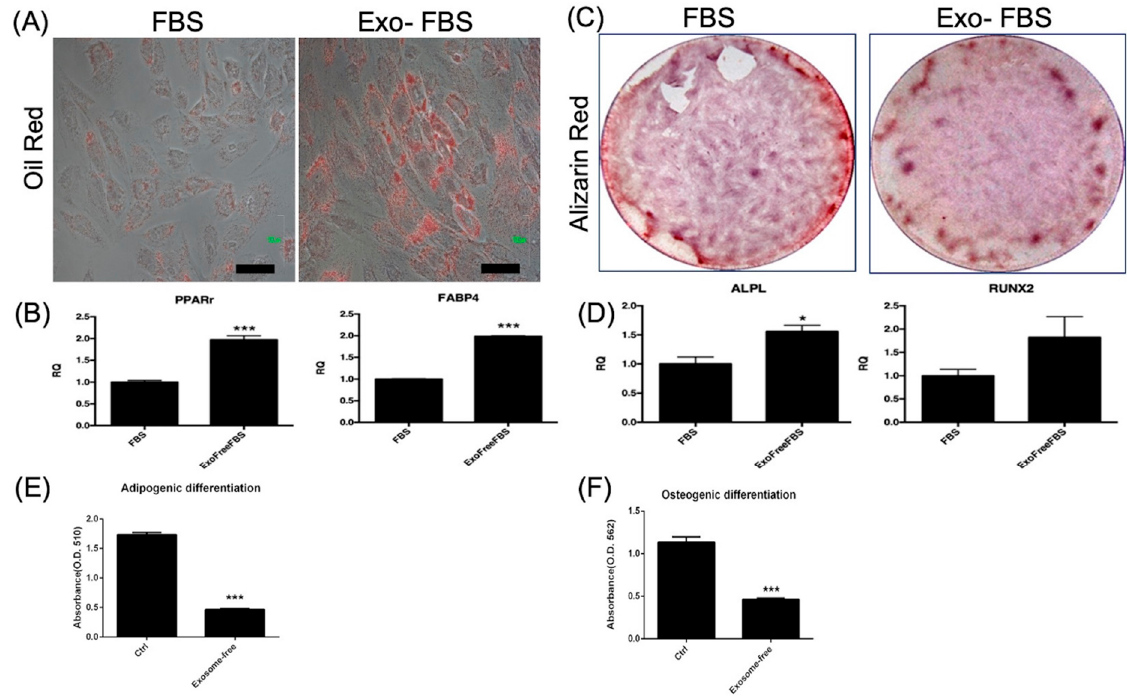
Figure 2. Adipogenesis and osteogenesis of HUCMSCs cultured with exosome-depleted and con- ventional fetal bovine serum (FBS). ( A ) Adipogenesis for 2 weeks and HUCMSCs-differentiated adipocytes showed positive staining of oil red. Scale bar = 100 µ m. ( B ) Quantitative polymerase chain reaction (qPCR) analysis of adipocyte gene expressions (PPAR- γ , FABP4). *** p < 0.001. ( C ) Osteogenesis for 2 weeks and HUCMSCs-differentiated osteoblasts showed positive staining of alizarin red. Scale bar = 100 µ m. ( D ) qPCR analysis for osteoblast gene expressions (APAL, RUNX2). * p < 0.05. ( E ) Absorbance (O.D. = 510 nm) of oil red. ( F ) Absorbance (O.D. = 510 nm) of alizarin red. *** p < 0.001. Representative results from 3 experiments. HUCMSCs were derived from the same